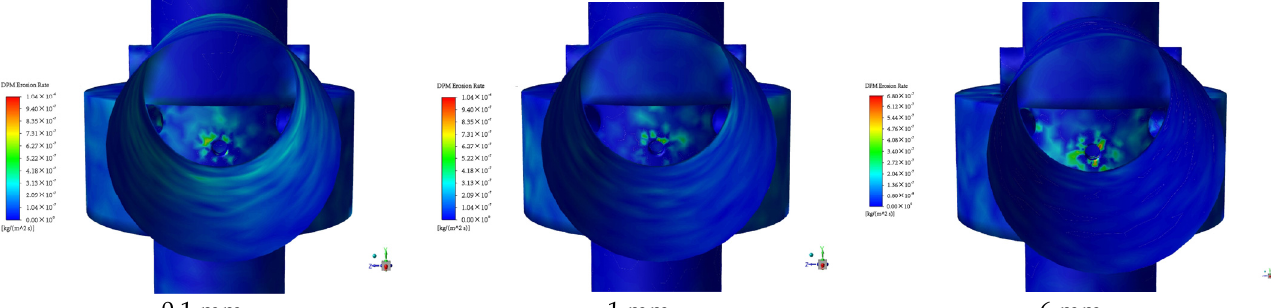
Figure 7. Erosion rate distribution under different gravel diameters.